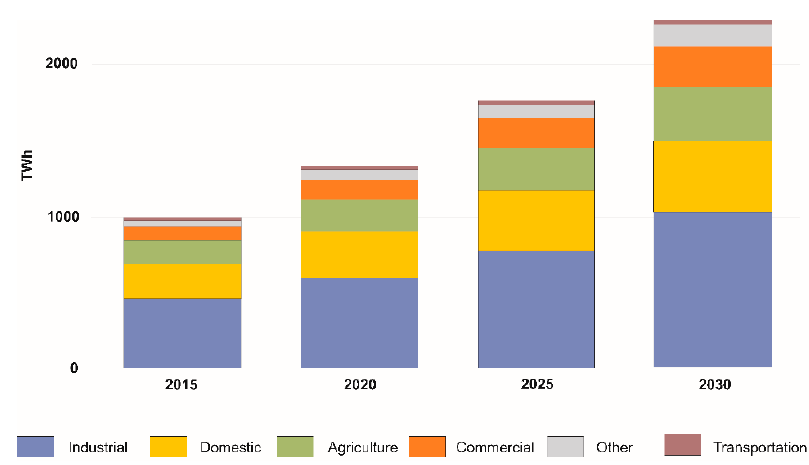
Figure 5 . Electricity consumption from different sectors in an energy-saving scenario. Figure 5. Electricity consumption from different sectors in an energy-saving